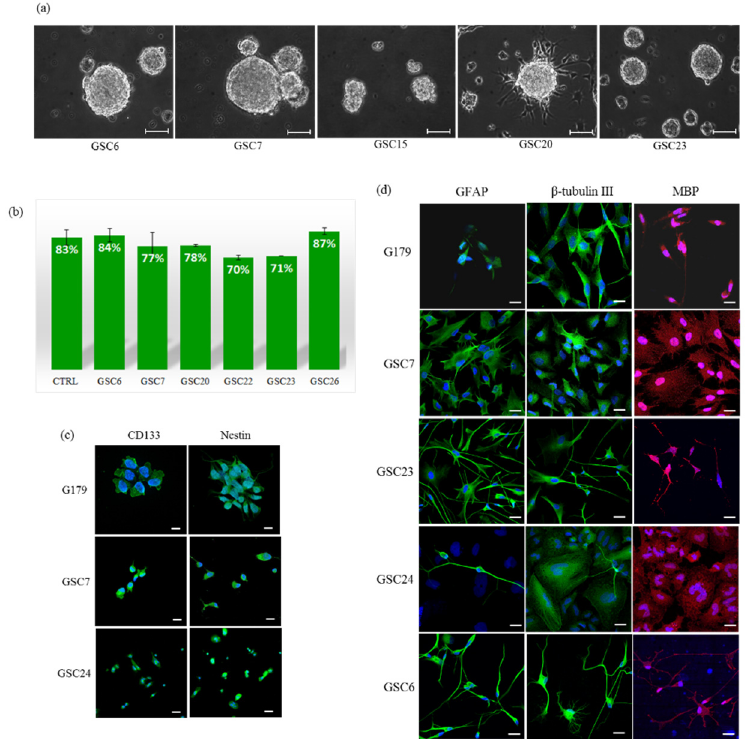
Figure 1. GSC primary cultures: ( a ) Representative images of glioblastoma patient primary cultures (GSCs) growth as floating or semi ‐ adherent tumorspheres. Images were captured at low ‐ passages (P4 and P5) with a Leica DFC290 Microscope Camera at magnification 20X. Unit of measurement bar = 100 µ m. ( b ) Self-renewal efficiency. Data shown are the mean ± SEM of two tests in triplicate for each culture. CTRL is the average of the positive controls (G166 and G179 stem cell lines). ( c ) Evaluation of stemness, and ( d ) differentiation markers. A G179 established glioma stem cell line was used as a positive control. Markers can be appreciated in green and red, while nuclei are stained in blue (DAPI). The images refer to areas particularly enriched with cells positive for the specific marker. Unit of measurement bar = 20 µ